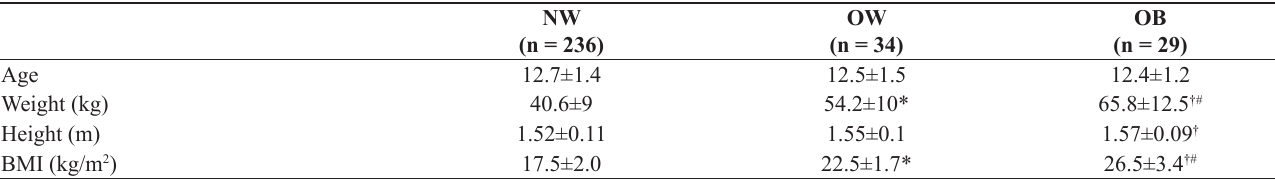
Table 1. Anthropometric characteristics of participants aged 10-14